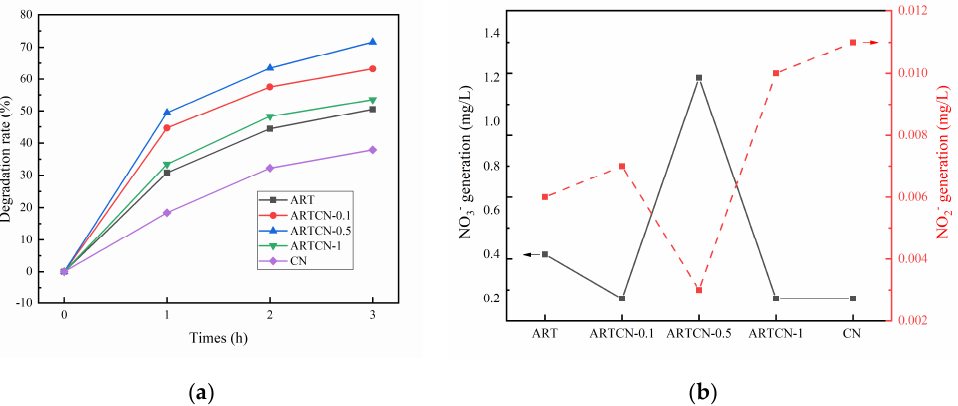
Figure 8. Degradation of the liquid ammonia by samples ( a ); NO 3− and NO 2− production after the reaction ( b ).